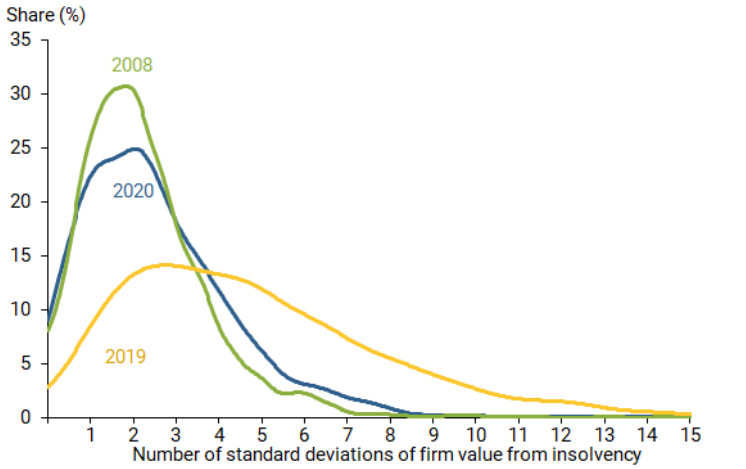
Fig. 1 The relationship curve between default distance and expected default